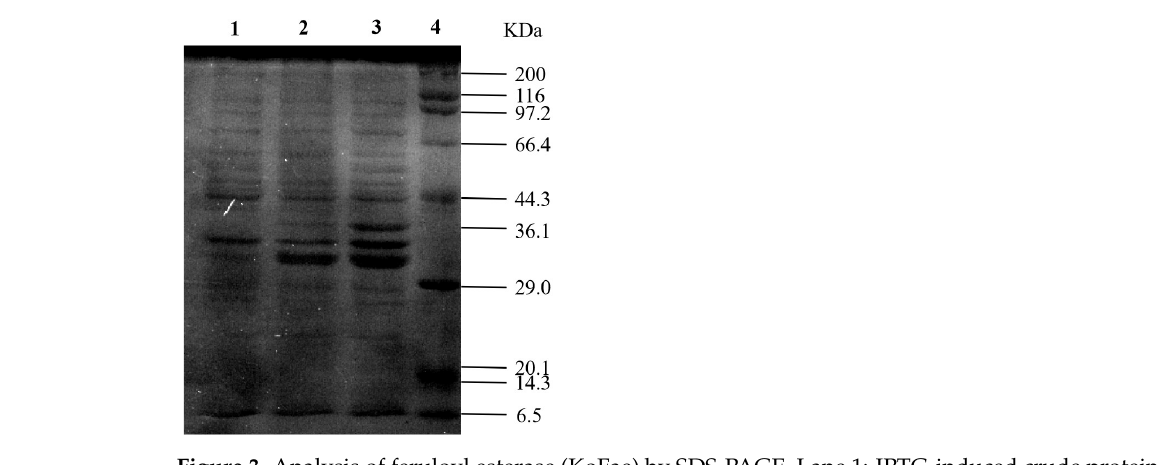
Figure 3. Analysis of feruloyl esterase (KoFae) by SDS-PAGE. Lane 1: IPTG-induced crude protein expressed by E. coli carrying plasmid pET-28a; lane 2: IPTG-induced ultrasound-treated supernatant of E. coli carrying plasmid pET-28a-KoFae; lane 3: I IPTG-induced crude protein expressed by E. coli carrying plasmid pET-28a-KoFae; lane 4: standard protein marker.